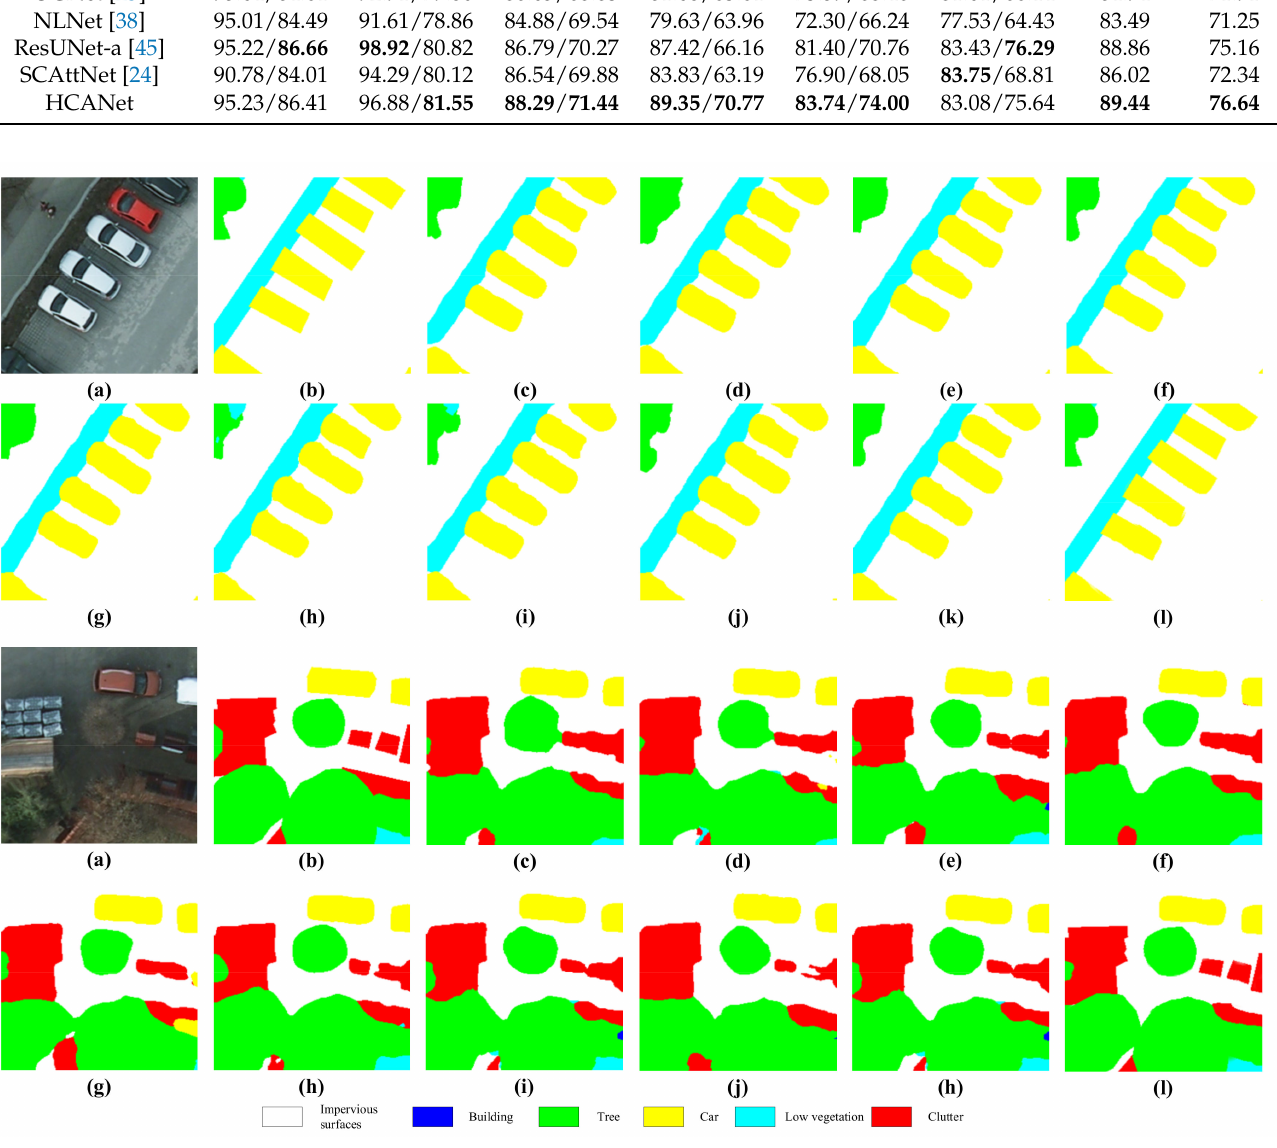
Figure 7. Visualization results on the Potsdam test set. ( a ) Original image, ( b ) Ground truth, ( c ) SegNet, ( d ) U-Net, ( e ) DeepLab V3+, ( f ) CBAM, ( g ) DANet, ( h ) OCNet, ( i ) NLNet, ( j ) ResUNet-a, ( k ) SCAttNet, ( l )